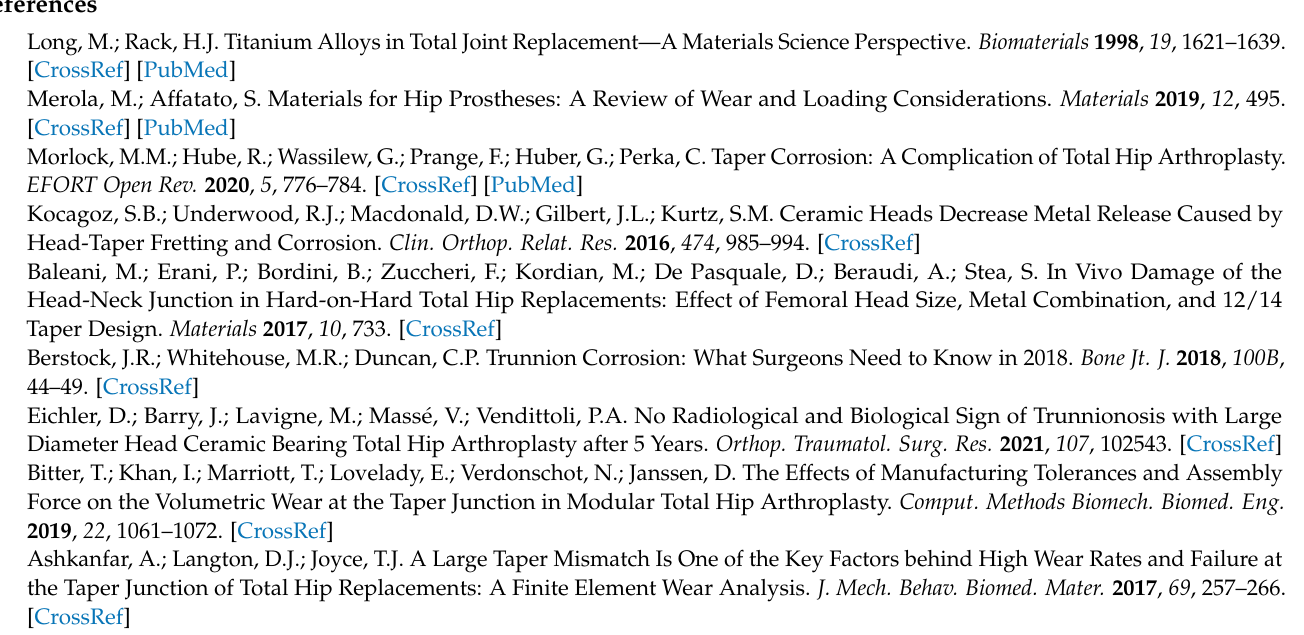
hip prostheses; Figure S2: Clinical details of the 15 explant triads; Figure S3: Mean values of Goldberg scores for proximal, middle, and distal regions (error bars represent one standard deviation); Figure S4: Changes in roughness profile (taper tip on the left) in the proximal (1), middle (2), and distal regions (3). The reference profile is shown in green colour; Table S1: Reason for revision of the 45 explants; Table S2: Goldberg scores; Table S3: Percentage changes in roughness